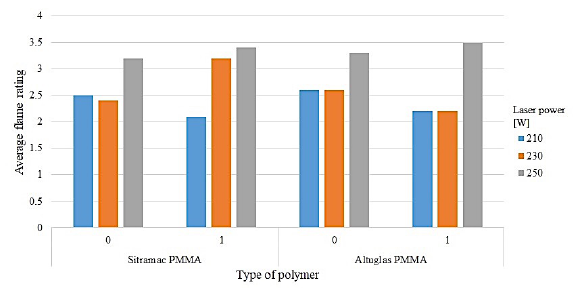
state laser, laser power was set to 210 , 230 and 250 W . Figure 2. Average flaming rates during direct laser welding of steel-PMMA